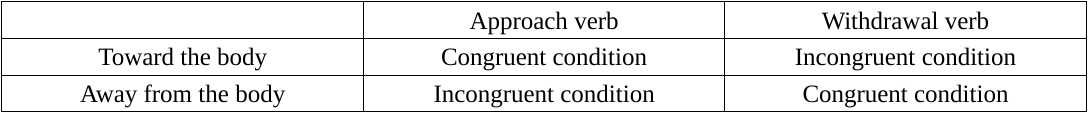
Table 1 - The design of the